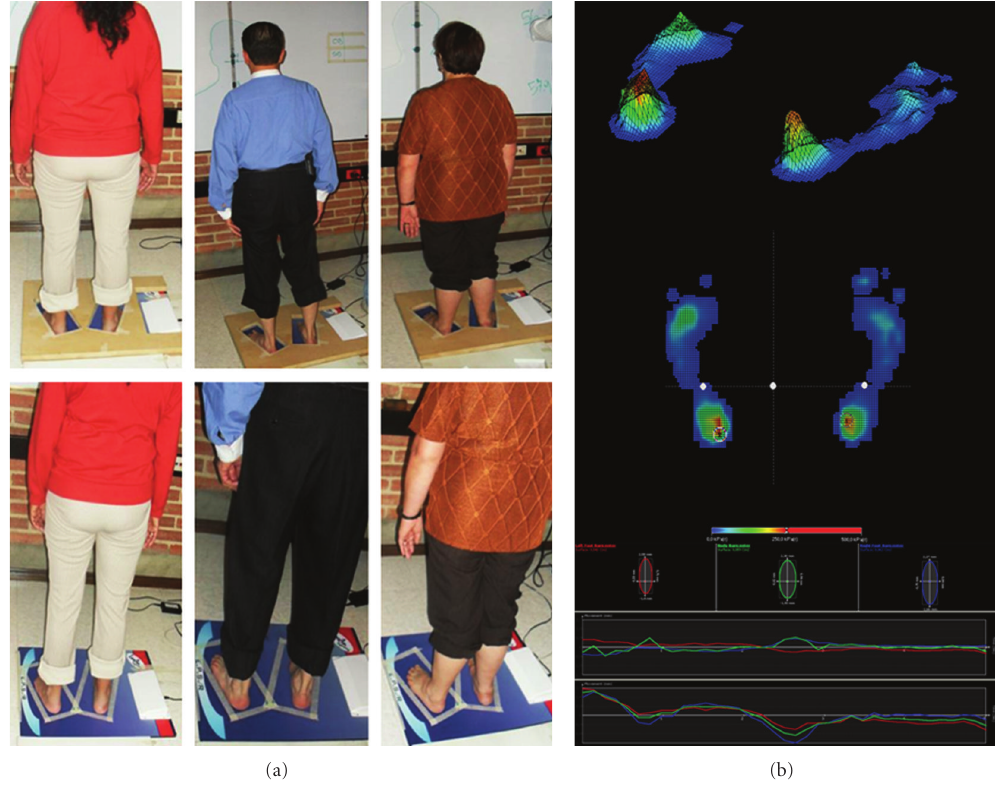
Figure 4: Normal subjects with the 3D guide and 2D guide techniques for pressure measurements. Table 1: Student’s t -test analysis. Sample of features in male subjects M1 and M4 during 3 sessions with the 3D guide ( P > . 000125 → “+,” P < . 000125 → “ − ”).